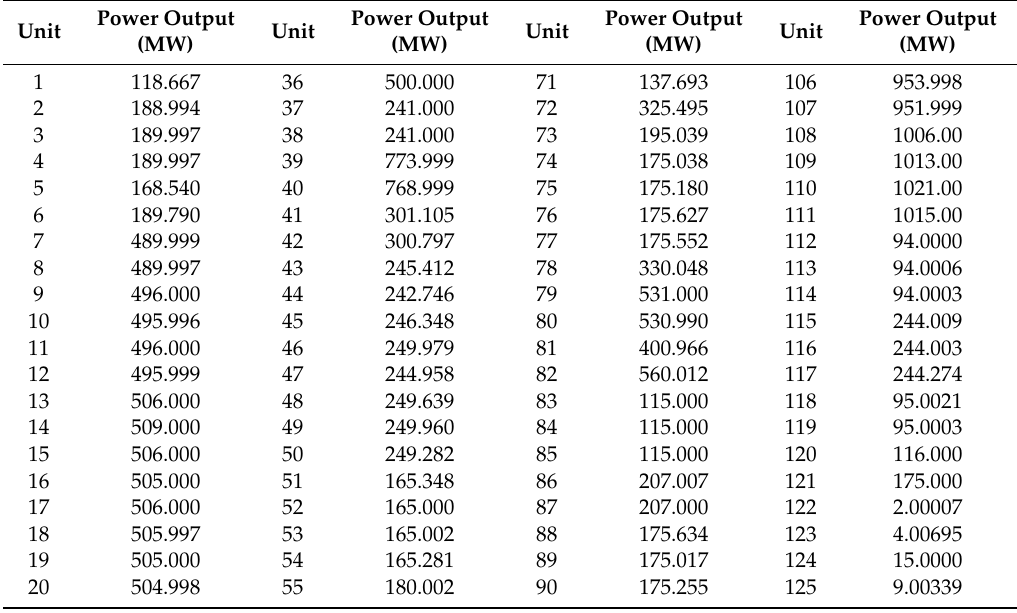
Table 14. Best outputs for test case 4 with PD = 49342 MW (140-units system).